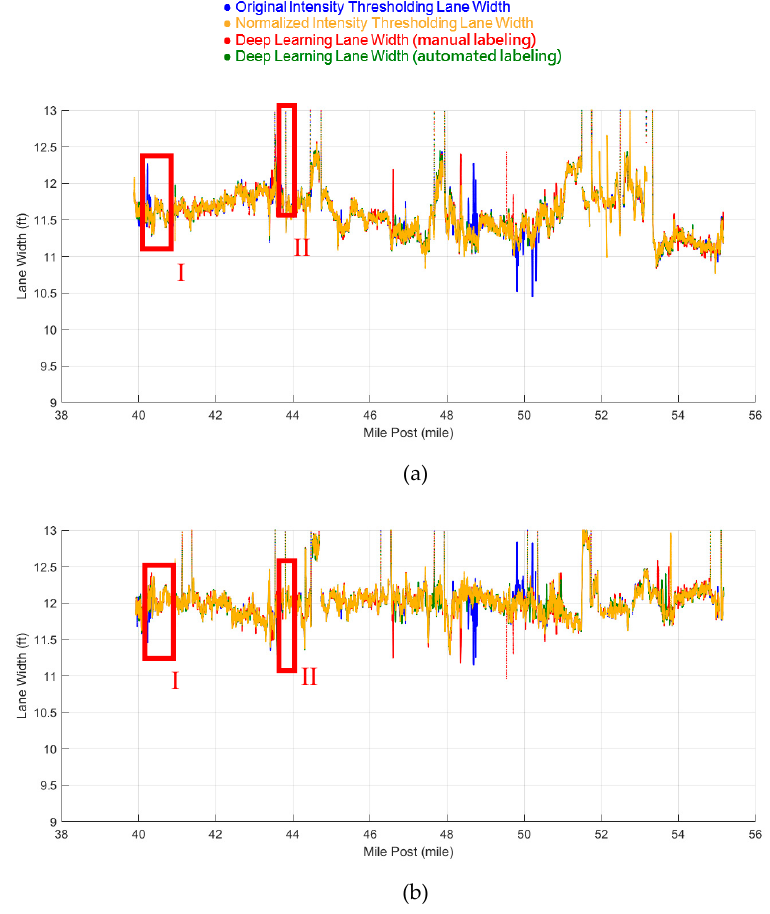
Figure 31. Estimated lane width values in ( a ) lane 1 and ( b ) lane 2 for dataset 3. Table 10. Lane width di ff erence statistics for di ff erent lane marking extraction strategies in dataset 3. Normalized Original Intensity Strategy Intensity Thresholding